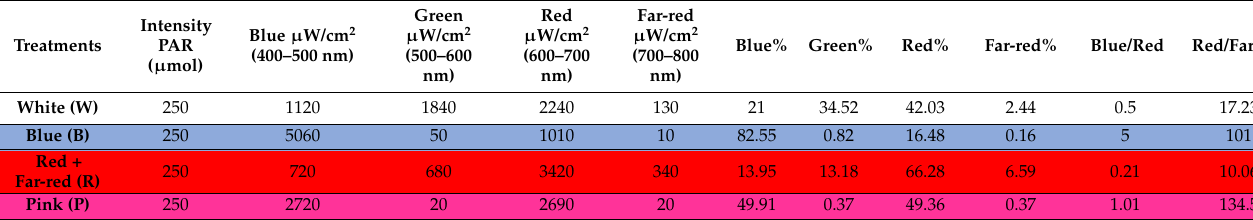
Table 3. Characteristics of light